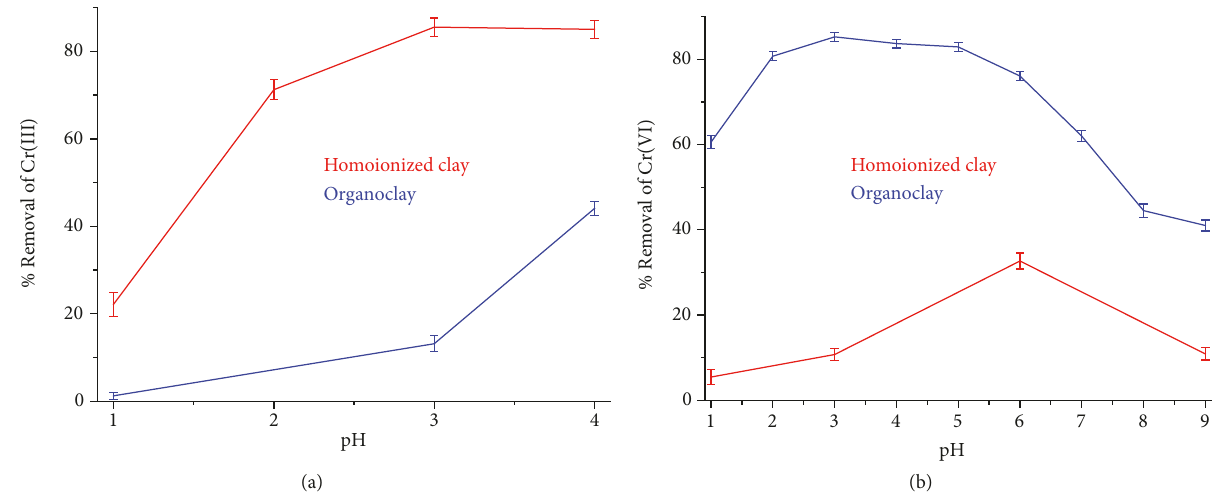
Figure 9: Adsorption of (a) Cr(III) and (b) Cr(VI) on homoionized clay and organoclay. The error bars represent the standard deviation of measurements of Cr in three adsorption tests.